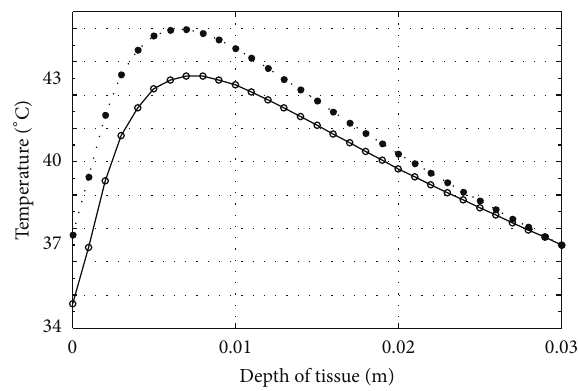
Figure 7: Temperature distribution at 𝑡 = 1000 s for two different thermal conductivities of casing layer. Solid line: 𝑘 cl = 0.14 W/m ∘ C, = 0.11 W/m ∘ C, 𝑈 = 150 W/m 2∘ C. 𝑈 = 175 W/m 2∘ C; dashed line: 𝑘 cl